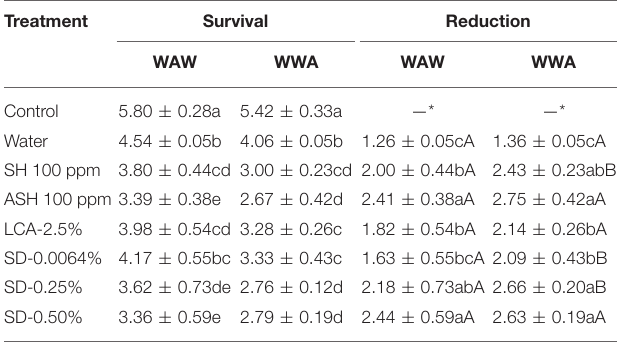
— * Indicates reduction data are not available. Mean values with different lowercase letters within a column are significantly different ( P < 0.05) . Mean values with different capital letters within a row are significantly different ( P < 0.05) . TABLE 2 | Survival and reduction of Salmonella Typhimurium and Tennessee on tomatoes (log CFU/tomato) by triple-wash procedure WAW or WWA in water, SH